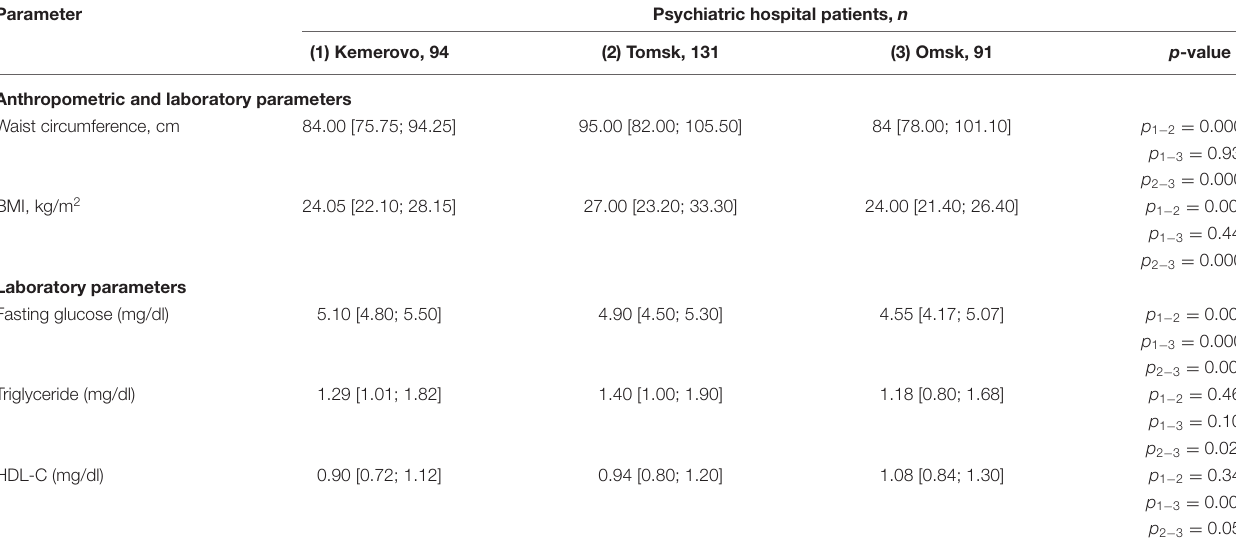
TABLE 7 | Comparative characteristics and evaluation of anthropometric and laboratory parameters in the study population (Me [Q1; Q3]).